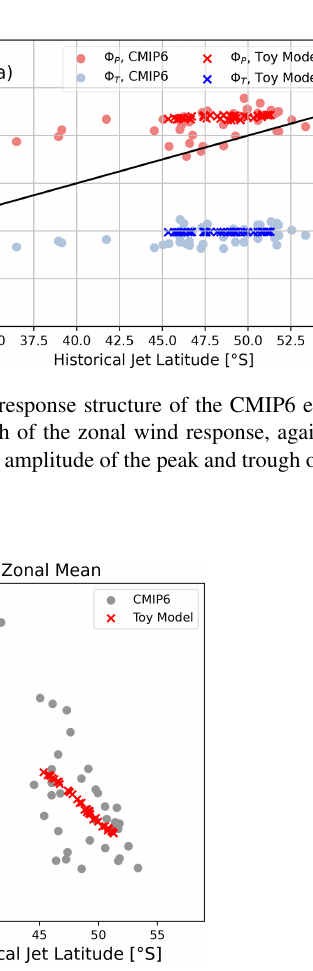
Figure 7. As in Fig. 2a with the results from the toy model